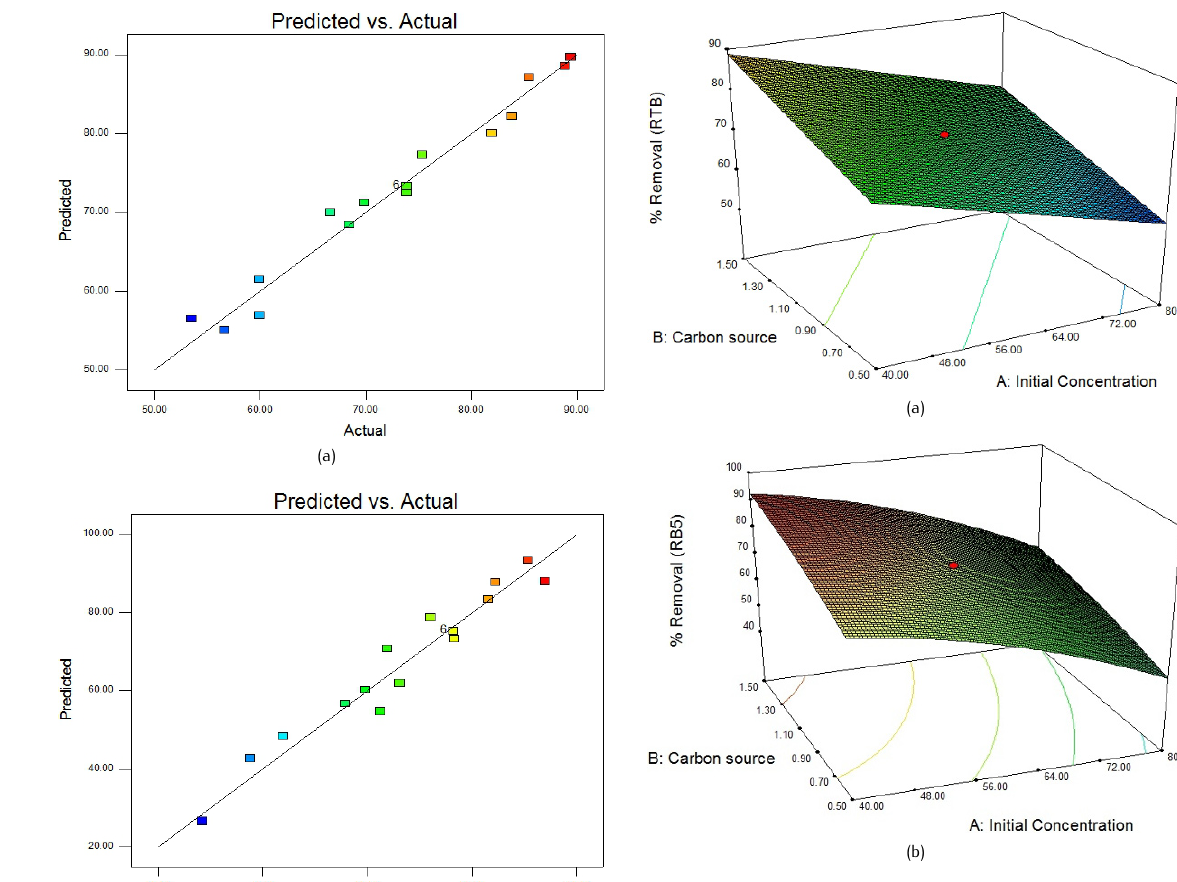
concentrations were the optimal value for complete removal of RTB and RB5.